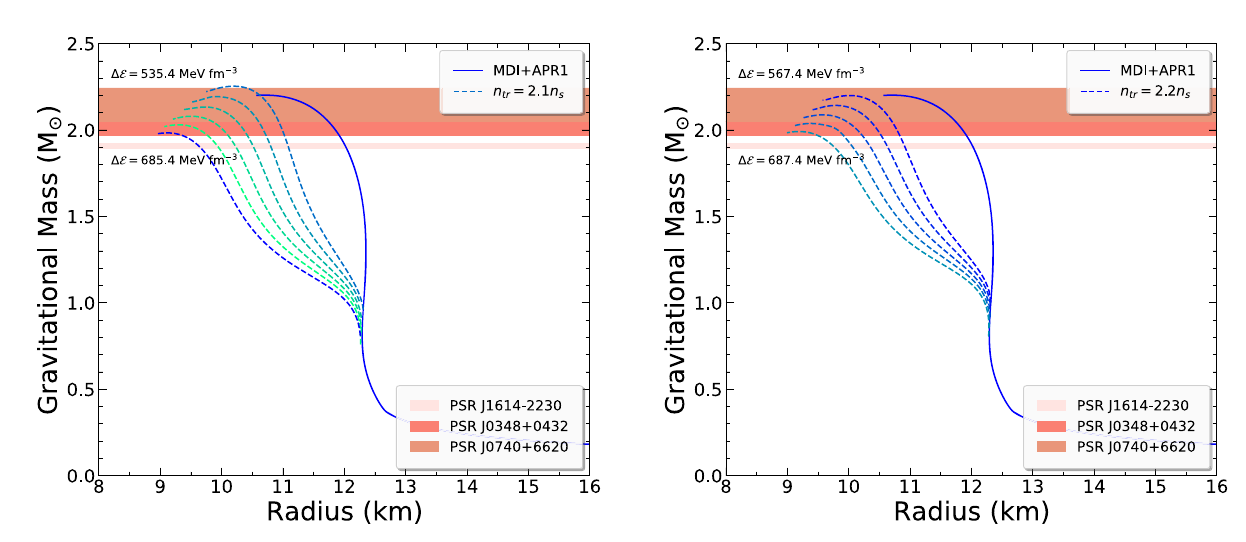
Figure 1. Mass-Radius diagram in the case of a sharp transition at n tr = 2 . 1 n s (dashed lines) for various values of the energy density jump Δ E . The solid line refers to the absence of a phase transition and is added for comparison. The coloured strips near the top of the figure denotes the range (uncertainty) around the maximum observed mass values of three pulsars [28–30].